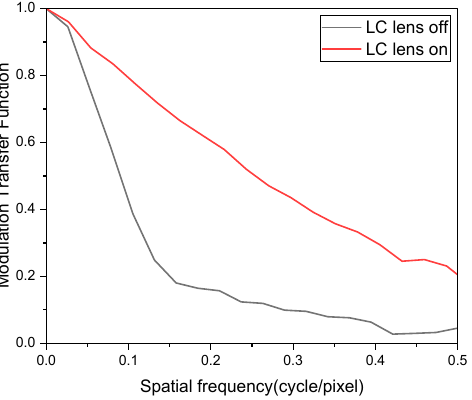
Figure 11. The modulation transfer functions corresponding to the lens ‐ off and lens ‐ on states.